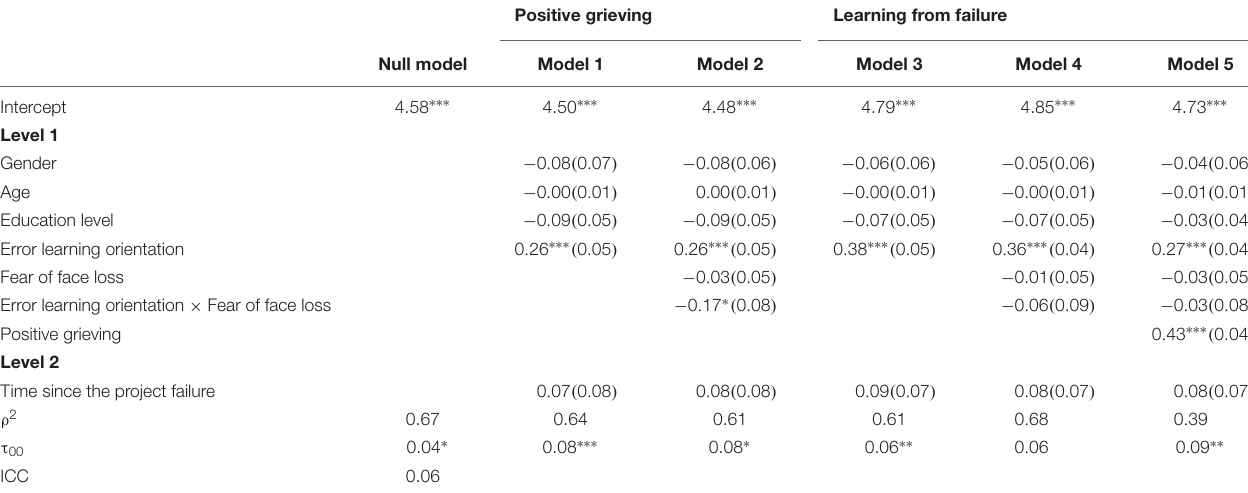
TABLE 3 | Multilevel estimates for